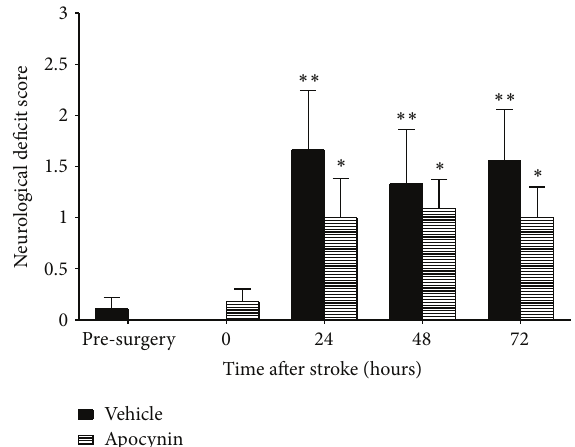
F 1: Effects of apocynin and vehicle treatments on functional outcome using the neurological de�cit score. Data are presented as mean SEM ( n = 11 apocynin treated; n = 9 vehicle treated). Each rat acted as its own control, with results aer stroke compared to prestroke scores and between treatment groups at the same time. ±